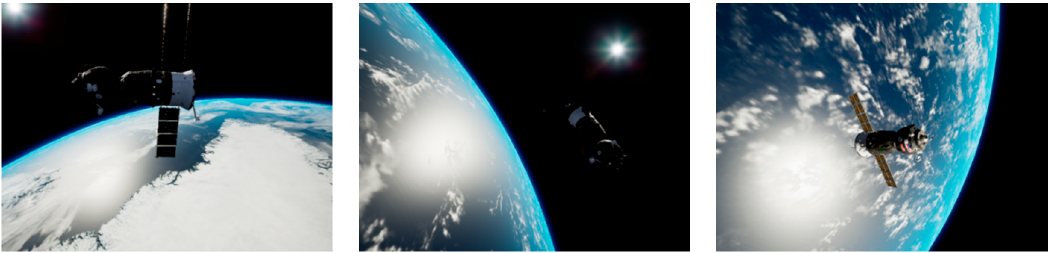
Figure 2. Sample images from the dataset.